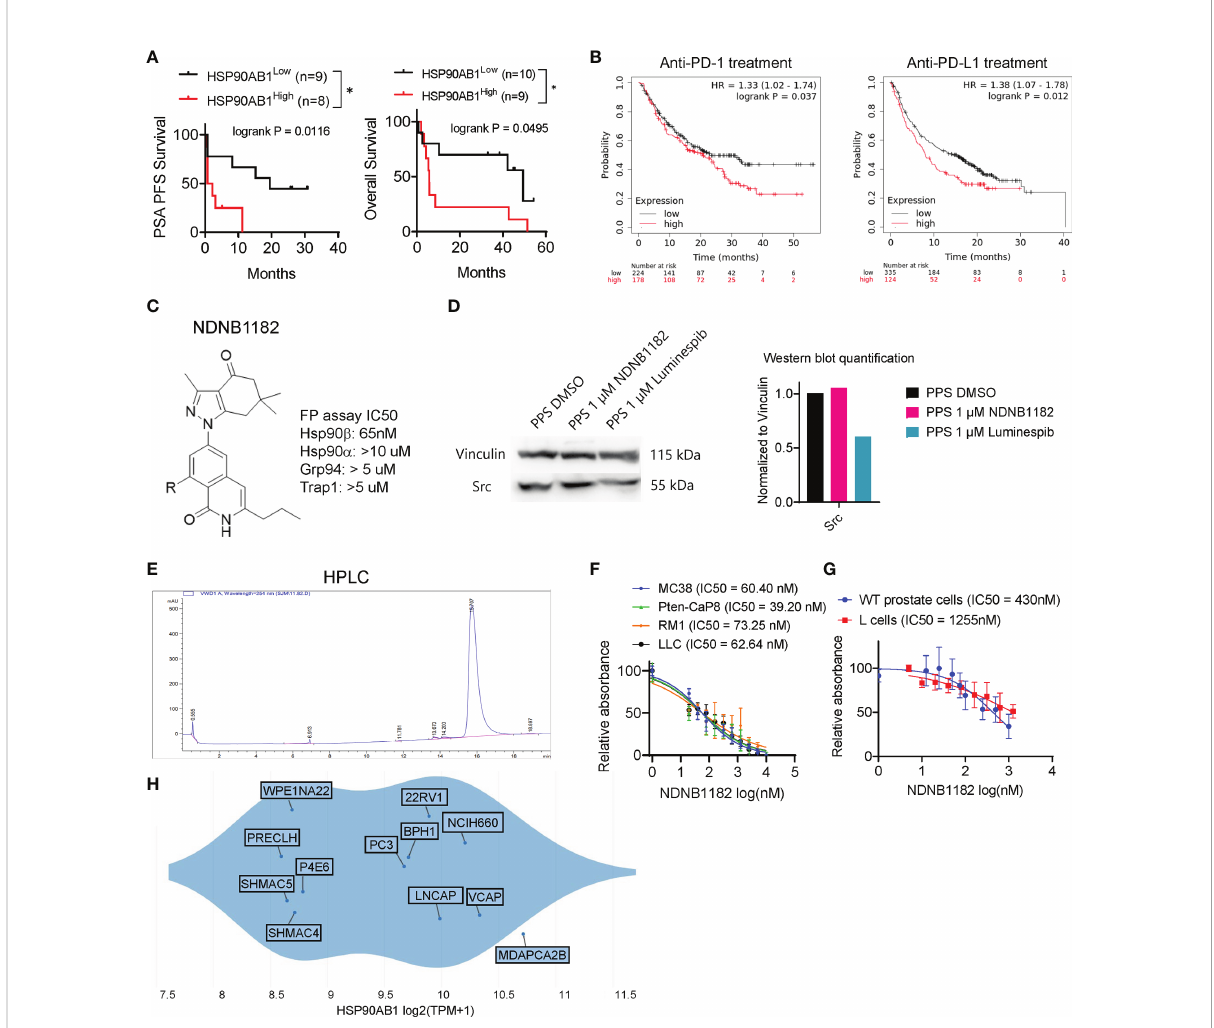
FIGURE 1 Hsp90 b -selective inhibitor NDNB1182. (A) Association of high HSP90AB1 expression with worse PSA progression free survival (PFS) and overall survival, with data extracted from the database of a phase 2 clinical trial of ipilimumab in metastatic castration-resistant prostate cancer *P<0.05, log rank test between the two cohorts (47). (B) Association of high HSP90AB1 expression with worse overall survival for anti-PD1 or anti-PD-L1 treatment with data from multiple clinical studies, drawn with KMplot. (C) The generic structure of NDNB1182 and IC50 values against Hsp90 isoforms determined using fl uorescence polarization (FP) assay. (D) Western blot of Src in mouse prostate cancer cell line PPS treated with DMSO, NDNB1182 or luminespib for 12 hours, with the semi-quantitative result presented on the right. (E) HPLC result con fi rming the high purity of NDNB1182. (F) Dose-response curves and IC50 values of NDNB1182 on four cancer cell lines. Nonlinear regression modeling with log (inhibitor) and normalized response of variable slopes was conducted in Graphpad Prism. (G) Dose-response curves and IC50 values of NDNB1182 on primary prostate epithelial cells grown from wild type C57BL/6 mice and the mouse fi broblast cell line L cells. (H) HSP90AB1 transcript levels for prostate-lineage cell lines in the Depmap database portal with the plot generated by